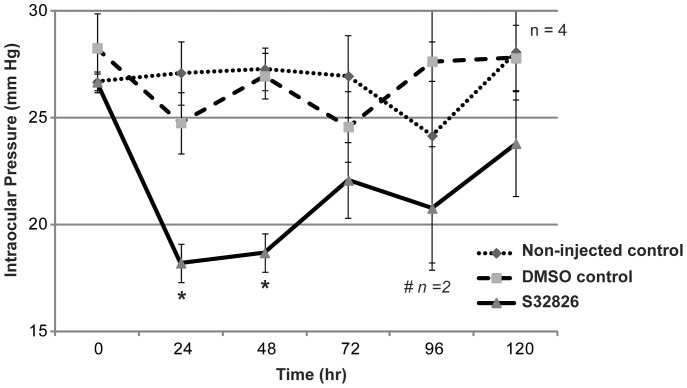
Intracameral injections of ATX inhibitor decreases IOP in rabbits.To determine the effects of intracameral delivery of S32826 on IOP, Dutch belted adult male rabbits (one eye from each animal, n = 4) were intracamerally injected with 5 µl of 100 µM drug. IOP was monitored in drug treated and contralateral (untreated) control eyes using a pneumotonometer. Drug treated eyes showed a significant decrease in IOP from the baseline (by 6–7 mm Hg) at 24 and 48 hrs based on paired t-test. This IOP lowering effect continued for more than 96 hrs, with IOP gradually returning to basal value by120 hrs post- injection. Further, IOP in drug treated eyes was significantly reduced as compared to IOP of the contralateral untreated eyes and eyes treated with sham control (PBS containing 2%DMSO) based on the Wilcoxon Rank Sum test of differences in medians. For the sham treatment, we used the contralateral eyes of the same animals in which we tested the effects of drug, with the sham treatment being performed 2 weeks after completion of the drug treatments (n = 4 for drug treated, sham treated and untreated controls). However, at the 96 hr time point, IOP was recorded in only two of the four rabbits from the drug treated and untreated control groups. *P<0.05.